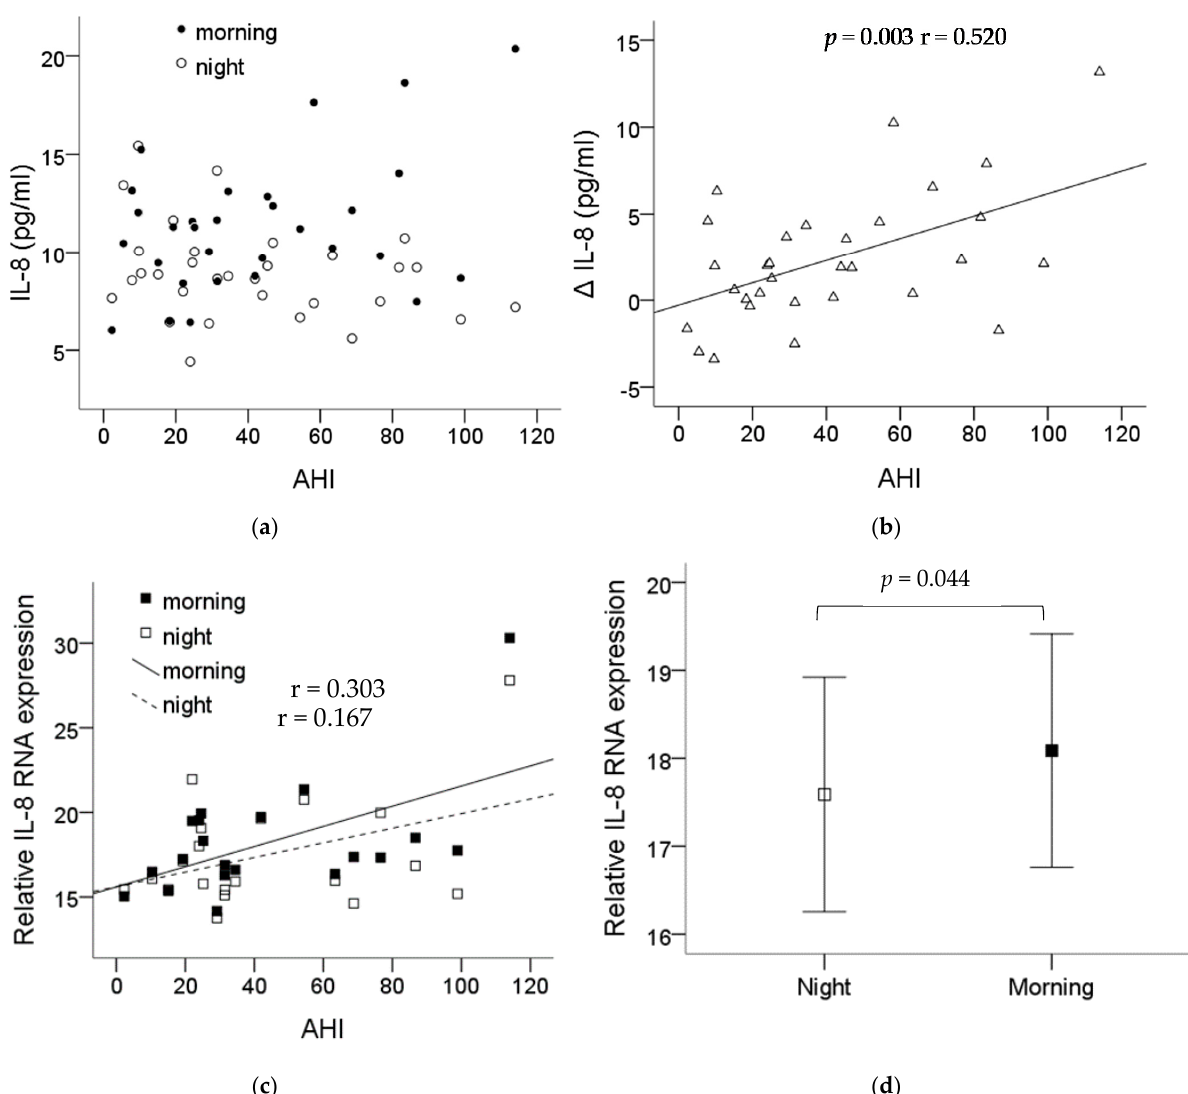
Figure 4. IL-8 expression significantly increased in the plasma and the monocytes of the OSA patients. Plasma was collected before and after the night PSG study, then submitted for monocyte isolation. ( a ) The levels of plasma IL-8 from each patient before and after the PSG study. ( b ) The difference in the plasma IL-8 levels before and after one night’s sleep was presented with Δ IL-8 which showed significant correlation with the severity of OSA ( p = 0.003, r = 0.520). ( c ) The monocytes IL-8 mRNA expression was also found to be increased along the severity of the OSA patients’ condition. ( d ) The expression of the monocytes’ IL-8 mRNA was elevated with statistical significance comparing the expression before and after one night’s sleep ( p = 0.044). Note: The data were presented as the means and the standard errors. Abbreviations: AHI = apnea–hypopnea index; IL = interleukin.